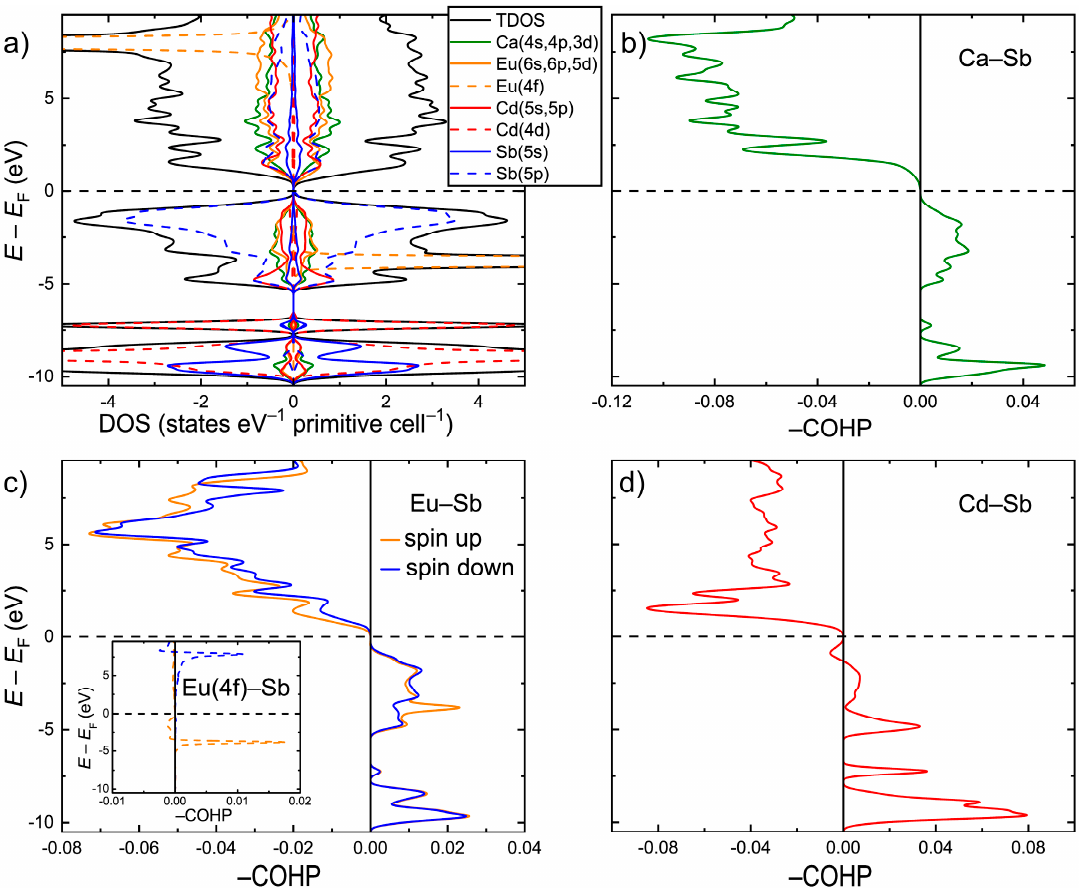
Figure 3. ( a ) Total and projected electronic densities of states (DOS) for the idealized CaEuCdSb 2 composition; ( b – d ) Crystal Orbital Hamilton Population curves (COHP) averaged over